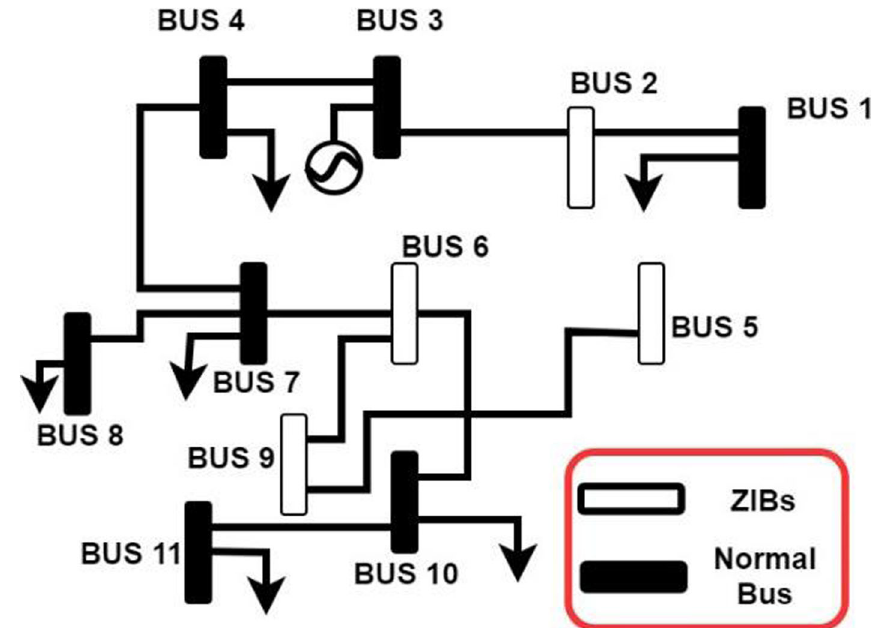
Fig. 7 Single Line Diagram of the Bihar Power Grid (including all buses), India